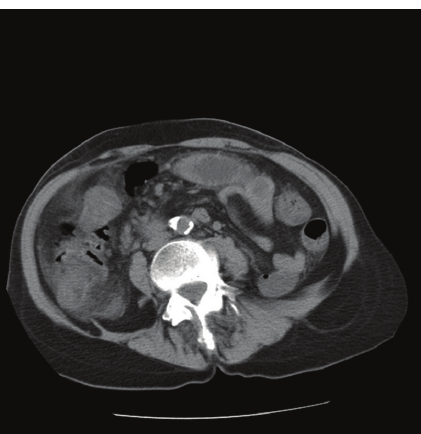
Figure 1: Acute colitis in the ascending and transverse colon.